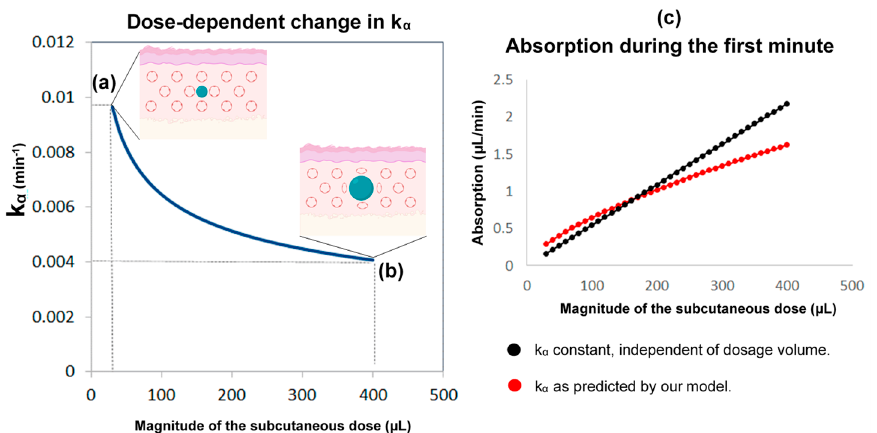
Figure 8. The reasoning behind the assumptions regarding the absorption rate of subcutaneous hydrocortisone (HC) administration. This rate depends on the subcutaneous dose magnitude, and the within-subject change in absorption rate with time. HC is a lipophilic molecule; its diffusion is hardly restricted by tissue membranes and thus can be assumed to be isotropic. Accordingly, we used a sphere as an approximation of the shape and movement of hormonal molecules infused into the subcutaneous tissue. Left : the higher the subcutaneous dose volume, the lower the absorption rate k α (k α is inversely proportional to the cubic root of the dose volume). When a small dose is administered by the pump cannula (e.g., 30 µ L or 0.3 mg of HC) ( a ), the ratio of the area of the sphere to its volume is approximately 2.4-times greater than when a 13-times larger dose is administered (e.g., 400 µ L or 4 mg of HC) ( b ). Therefore, the absorption rate drops to almost a similar degree (from about 0.01 to about 0.004). When administered in high doses, an increased fat deposition of the hormone could also contribute to dose-dependent changes in the absorption rate. Right : compared to the state where the absorption rate was considered constant and independent of the dosage, our assumption (of a dose-dependent k α ) indicates that in lower doses, the absorption would be higher, while in higher doses would be lower ( c ). Part of the Figure has been created with